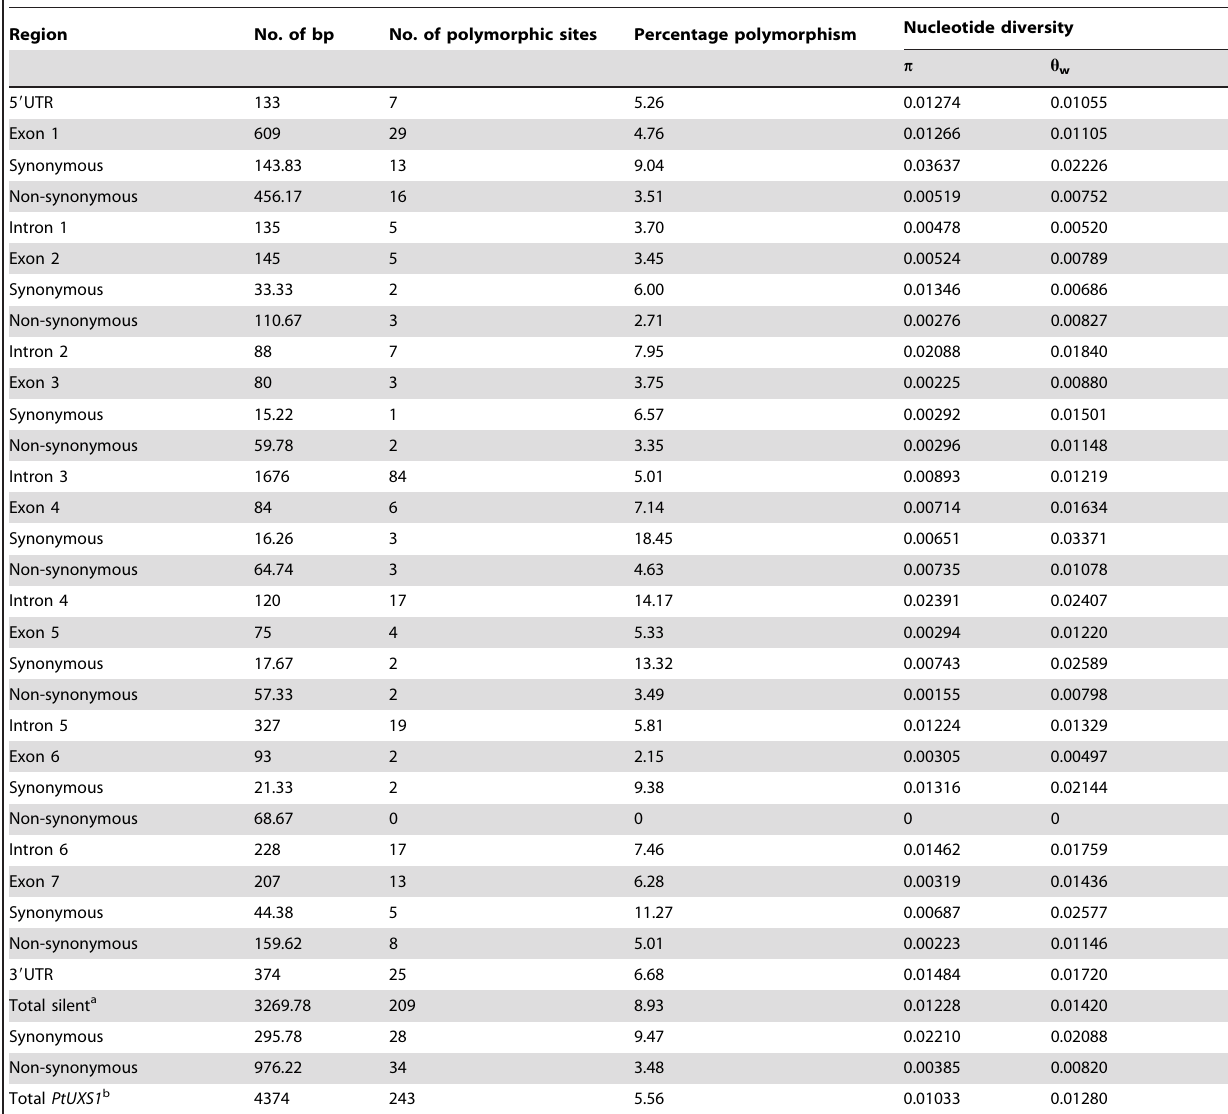
Table 3. Nucleotide polymorphism in PtUXS1 .